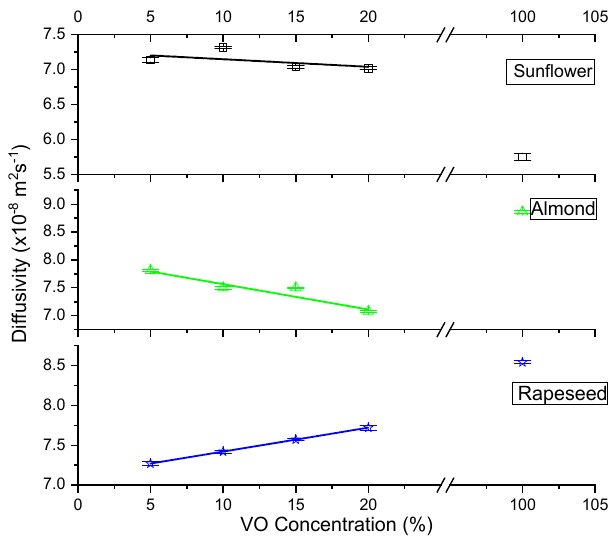
Figure 4. Thermal diffusivity values for sunflower (squares), almond (triangles), and rapeseed (stars); solid lines represent linear fitting in the 5% to 20% range for the corresponding samples. Table 1. The linear coefficient for thermal diffusivity behavior for the studied samples. Table 2. Obtained values for thermal effusivity and thermal